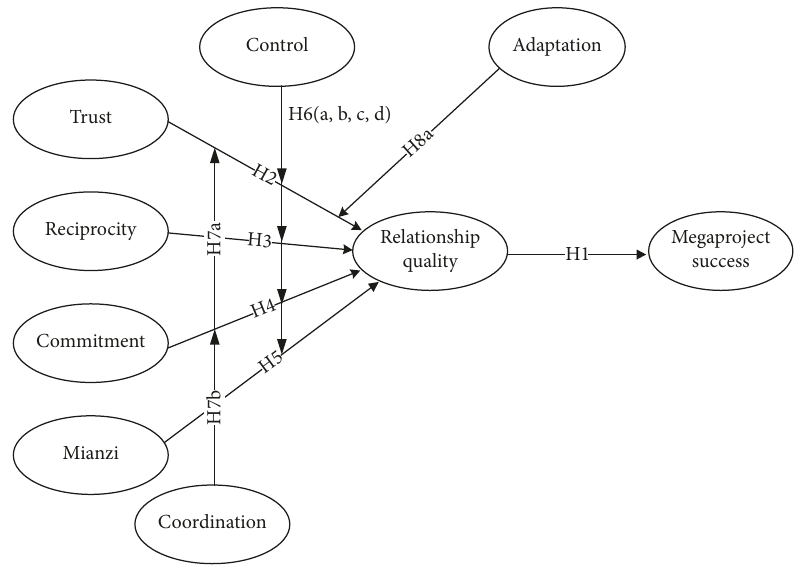
Figure 1: Research model and hypotheses. Table 1: Classification of